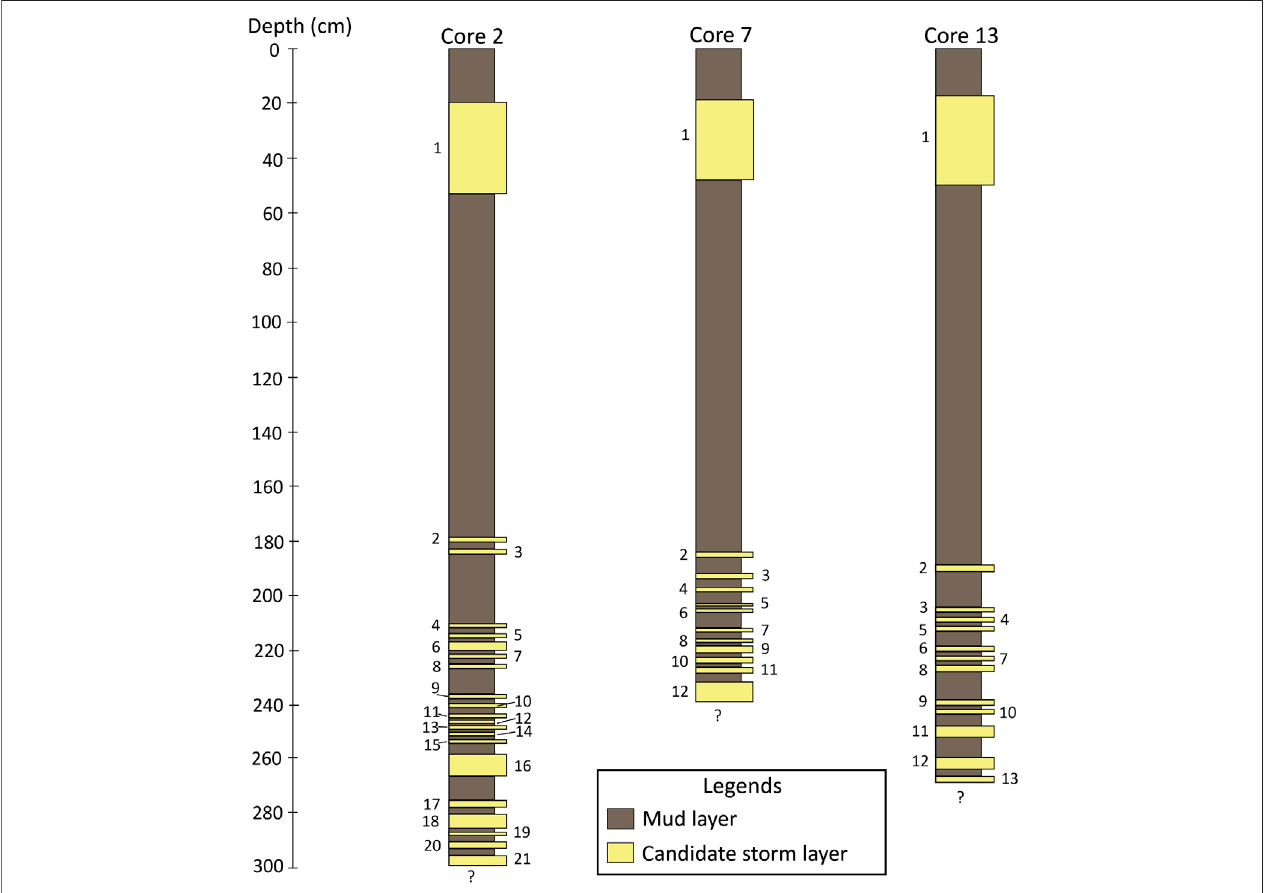
FIGURE 8 | Stratigraphic correlation of cores 2, 7 and 13 of transects 1, 2 and 3, respectively. These cores were drilled at the margin of a washover fan lobe to a depth of almost 3 m. Multiple layers of candidate storm sand sheets were extensively observed at depths between 180 and 280 cm. All candidate storm layers were referenced to the AMS dating of sand sheets with a depth comparatively correlated with Williams et al. (2016).